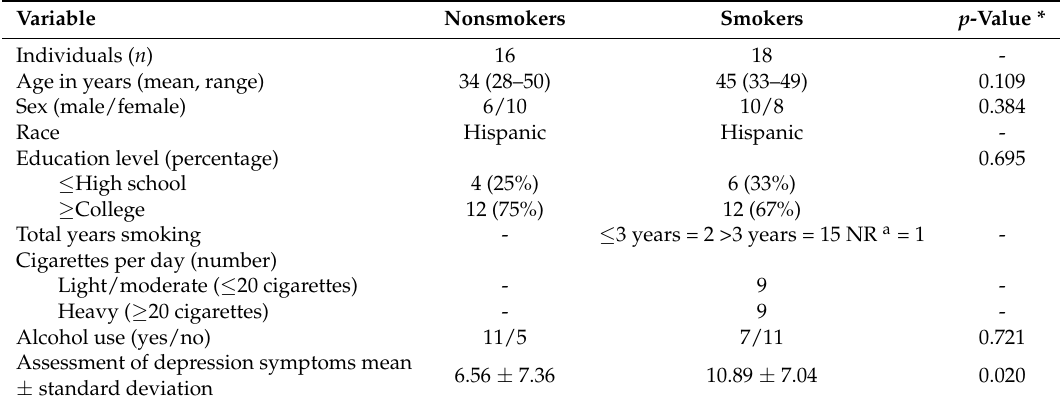
Table 1. Summary of study subjects by smoking status.